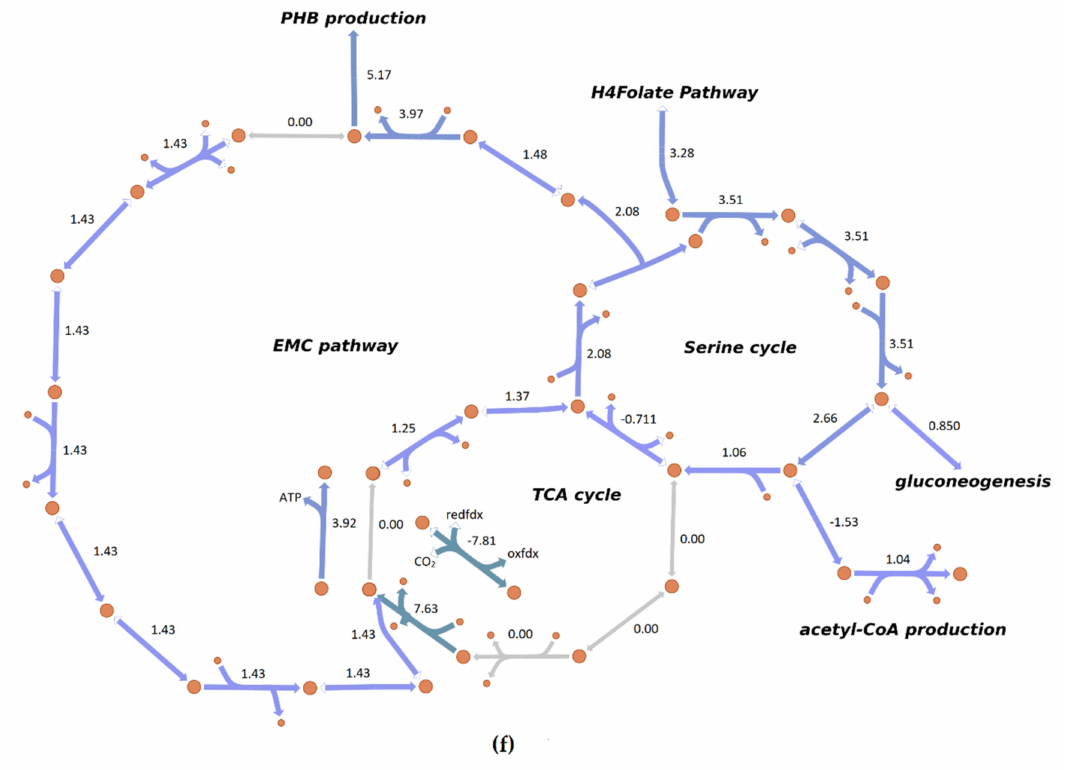
Figure 5. The flux distribution maps between the serine cycle, EMC pathway and TCA cycle. The maps were drawn with the help of Escher software [52]. The circles refer to metabolites, the